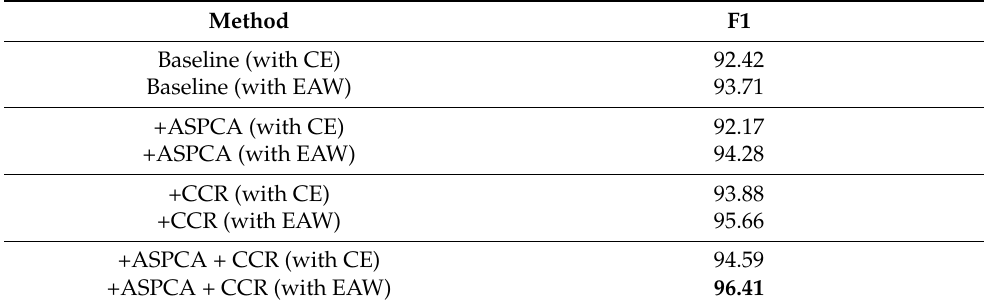
Table 4. Ablation study of proposed loss on CCD dataset. CE means cross-entropy loss. The bold type indicates the best result.